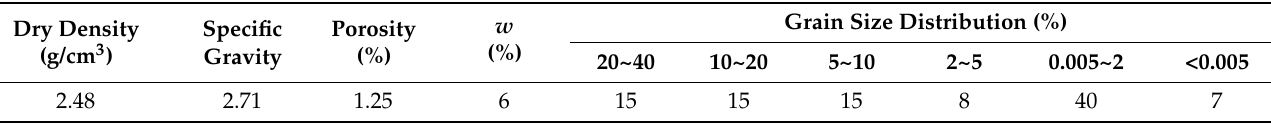
Table 1. Physical properties of the soil-limestone mixture.